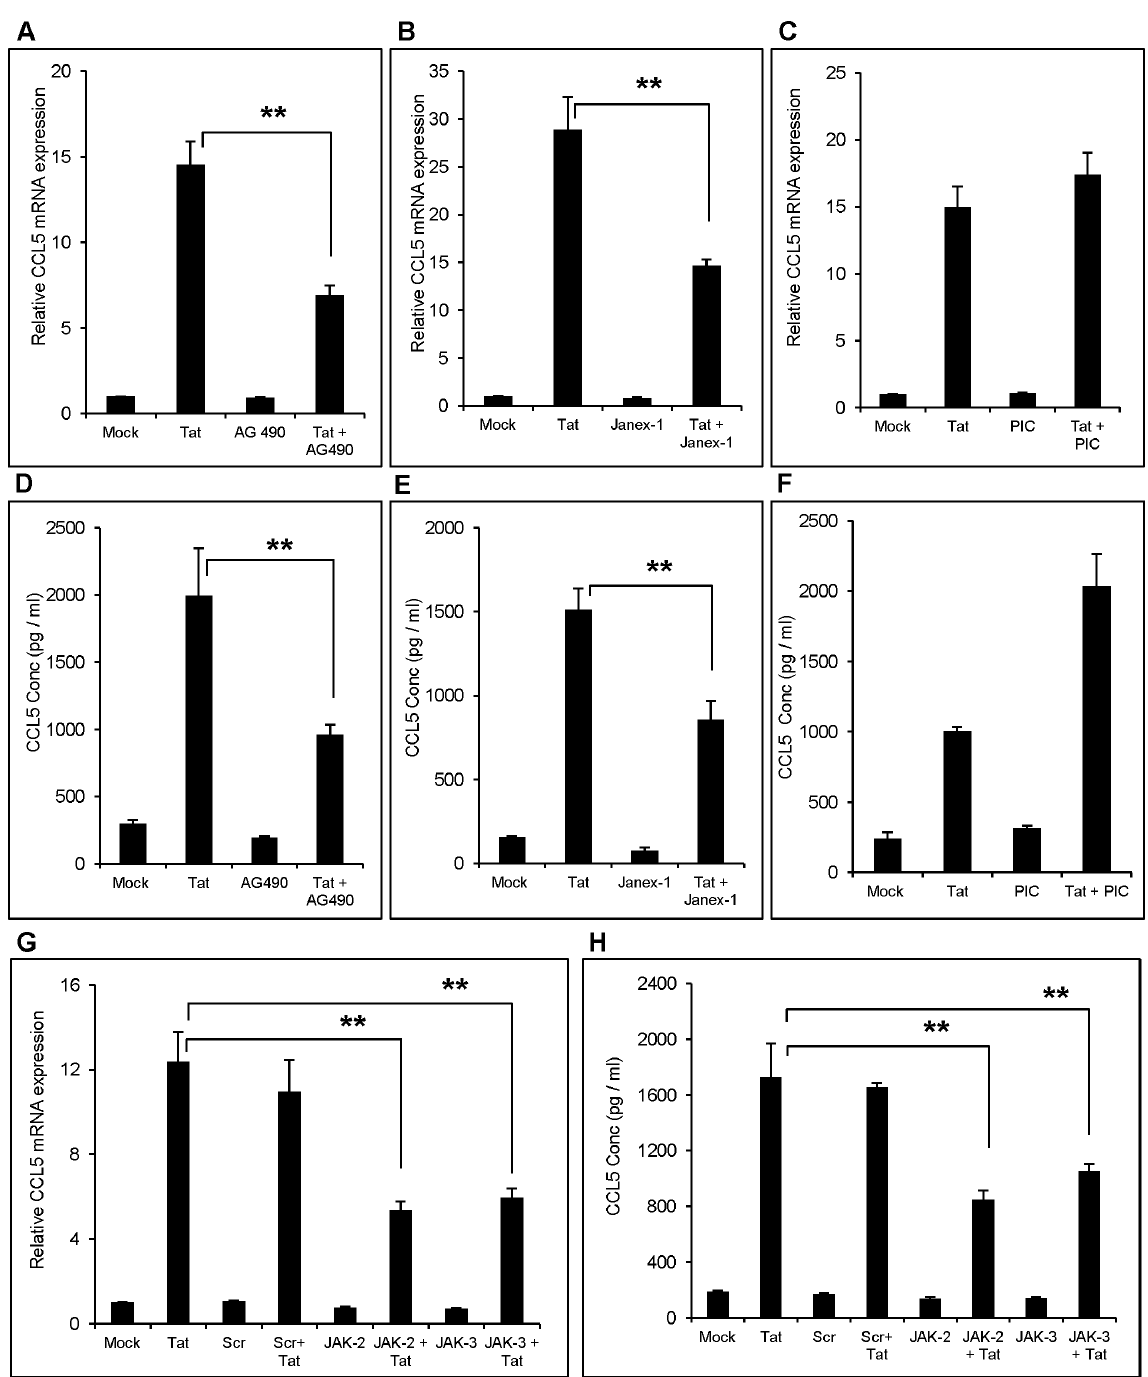
Figure 7. Role of JAK in the induction of CCL5 by HIV-1 Tat in astrocytes. SVGA astrocytes were pretreated with specific 10 m M JAK2 (AG490) (A,B) or 20 m M JAK3 (Janex-1) inhibitors (C, D) or 25 m M JAK1 (E, F) or siRNA to knock down JAK2 and JAK3 (G,H) prior to the transfection with HIV-1 Tat plasmid. The level of CCL5 induction was measured at mRNA (A, C, E, G) and protein levels (B, D, F, H). The values represented for mRNA are expressed relative to the mock-transfected controls. Each experiment was performed in triplicate and each bar in the figure represents the mean 6 SE of at least three individual experiments. One-way ANOVA was used to perform the statistical analysis and ** denotes p-value # 0.01.